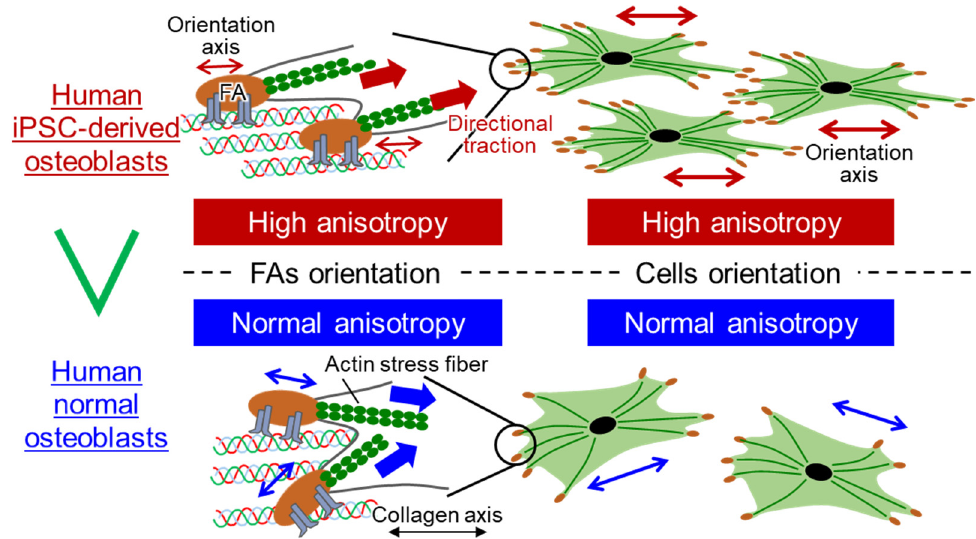
Figure 5. Schematic illustration of the relationship between cellular and FA properties in human induced pluripotent stem cell-derived osteoblasts (hiPSC-Obs) and normal human osteoblasts (NHObs). hiPSC-Obs exhibit a simultaneously enhanced orientation of FAs and cell reshaping along the collagen molecule substratum.